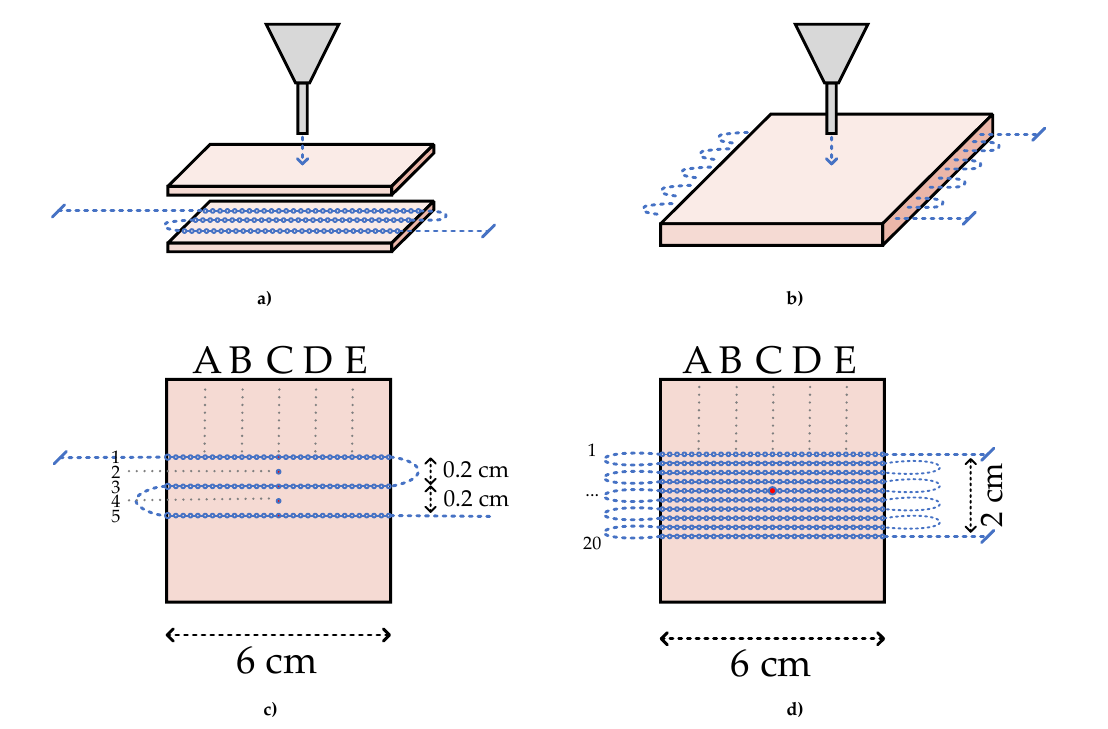
tance of 2 mm, and the rows indicate bent parallel fiber lines at a distance of 2 mm. Thus, the final matrix comprised 31 points for every three rows along the column.